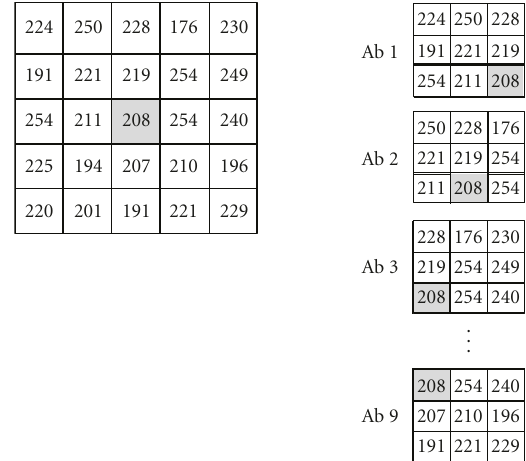
Figure 5: Initializing of the antibody